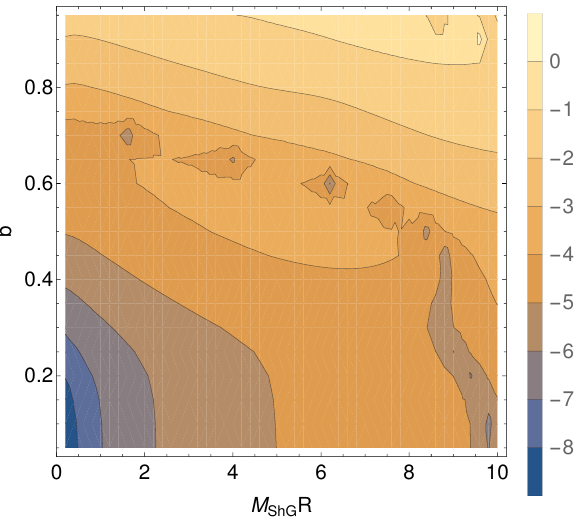
Figure 10. Base 10 logarithm of the normalized differences between the TSM ground state energies and their TBA counterparts for different couplings and